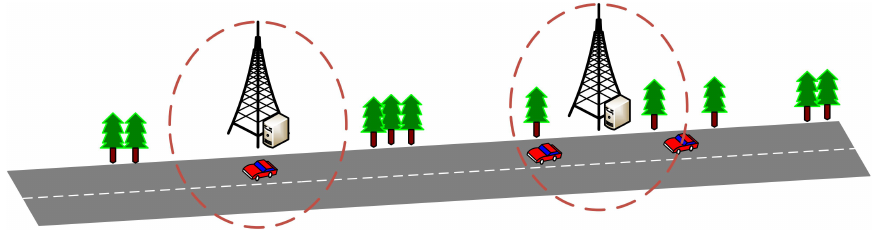
Figure 1. Vehicle edge computing environment.